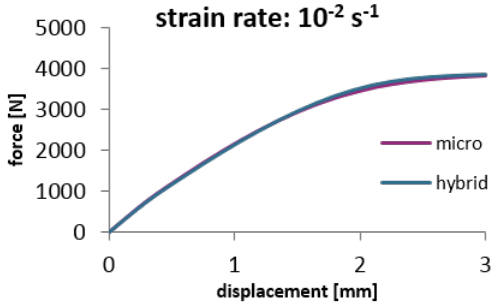
Figure 4. Comparison of hybrid and micro solution method.